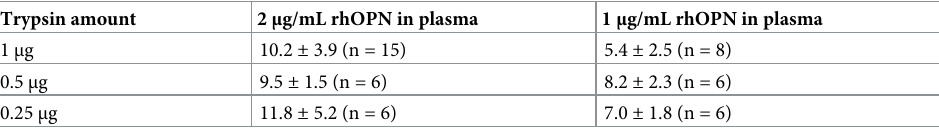
Table 4. MALDI-MS S/N data on peak m/z 1854.898 of trypsin digests of Elution fraction 3, from plasma samples, using different amounts of trypsin. Trypsin